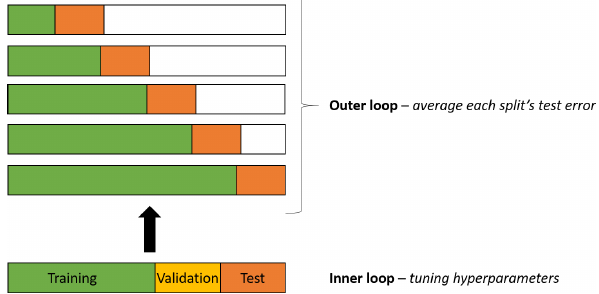
Figure B1. Monthly backward-chaining nested cross-validation procedure developed to test the generalization capacity of the model (modified after Cochrane,